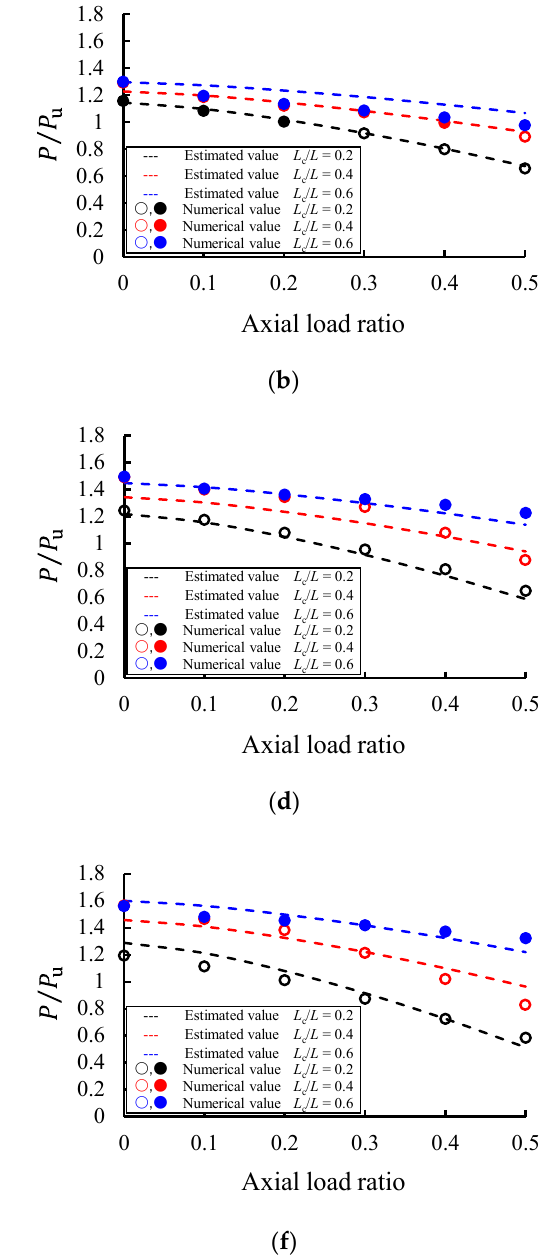
Figure 11. Maximum load bearing capacity and estimation equation for each model: ( a ) Model C-006-020; ( b ) Model C-006-040; ( c ) Model C-009-020; ( d ) Model C-009-040; ( e ) Model C-012-020; ( f ) Model C-012-040.